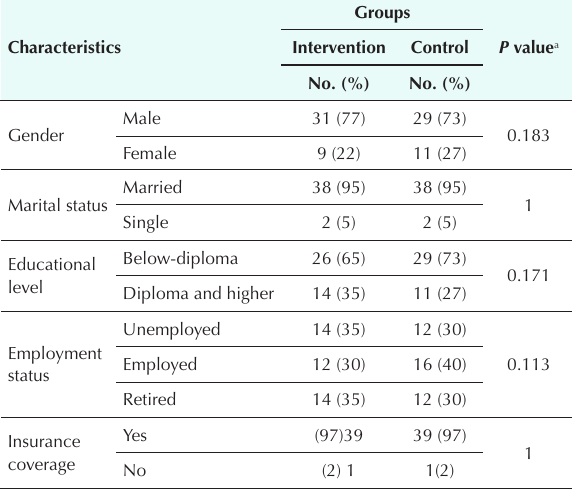
Table 1. Between-group comparisons respecting participants’ demographic characteristics